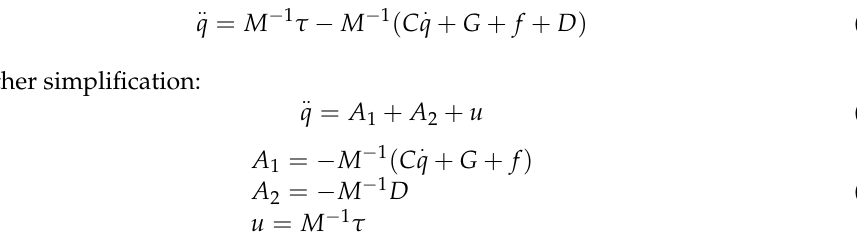
Figure 1. Schematic diagram of upper limb bilateral rehabilitation robot. ASM (the affected side manipulator) is used to assist patients to complete rehabilitation training tasks in a three-dimensional workspace.